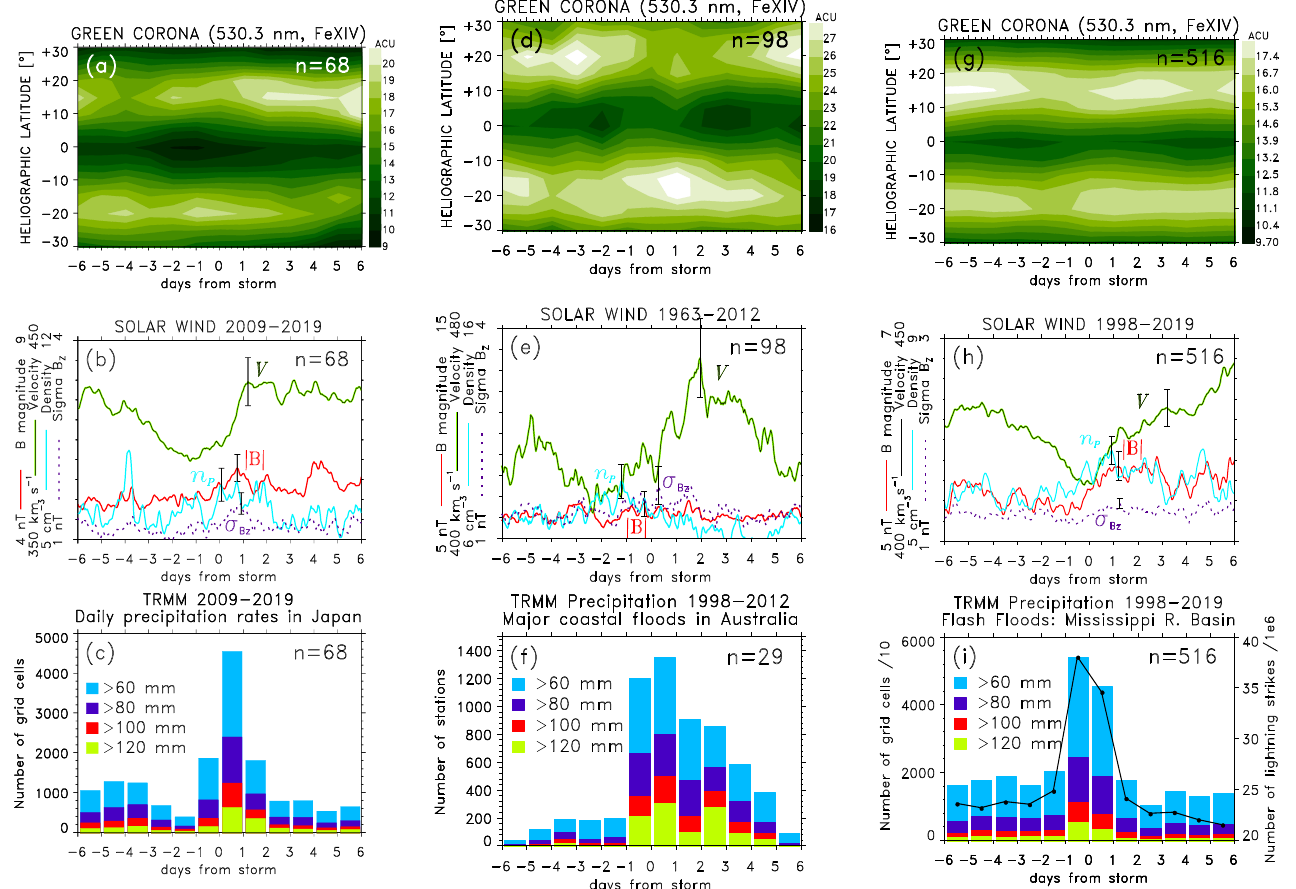
Figure 3. The SPE analysis of time series of ( a , d , g ) green corona intensity and ( b , e , h ) solar wind plasma variables keyed to start dates of heavy rainfall/floods/flash floods in Japan, south-eastern Australia and the Mississippi River Basin (MRB) in the U.S. Bottom panels ( c , f , i ) show the cumulative number of grid cells with above-threshold daily precipitation rates over Japan, south-eastern Australia and the MRB from the TRMM dataset. In the case of the MRB flash floods, the cumulative number of lightning strikes over the MRB region is also shown.